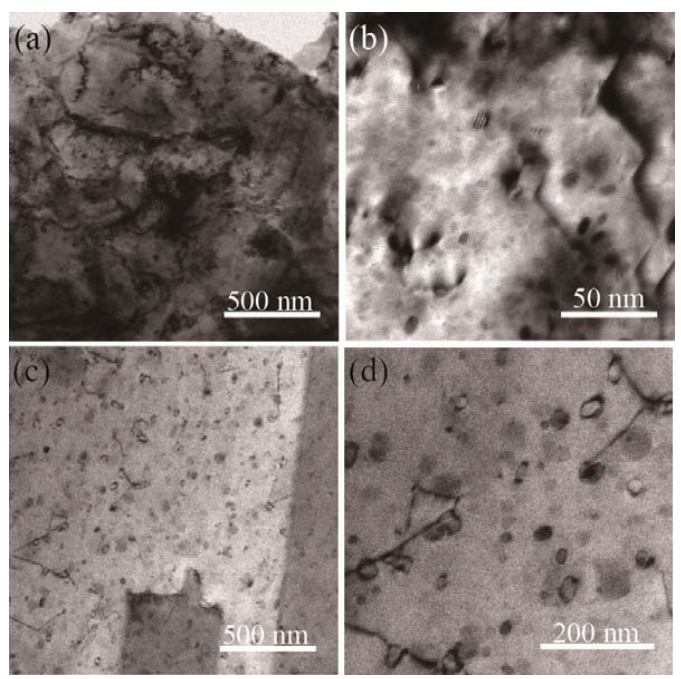
Figure 6. TEM images of the Cu–Cr–In alloy annealed at 650 °C for various times. ( a,b ) 60 min; ( c,d ) 240 min.